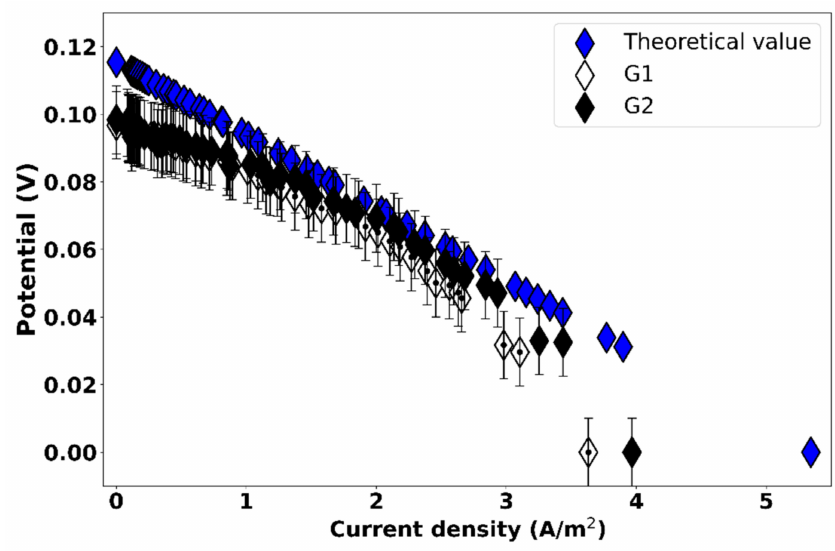
Figure 5. Comparison of V-I curves obtained with spacers G1 and G2 against the theoretical